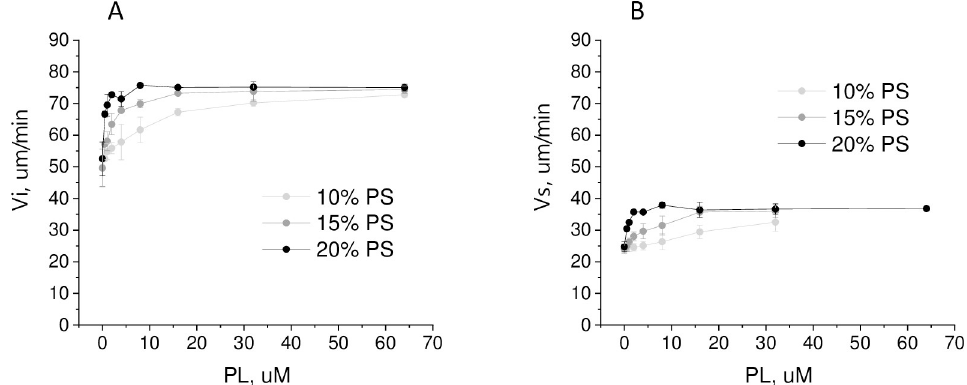
Fig 9. Influence of artificial vesicles on coagulation propagation. Mean ± sd dependence of the initial (A) and stationary (B) clot growth rates on the concentration of artificial phospholipid vesicles (PL) containing 10% (n = 3), 15% (n = 3) and 20% (n = 2)